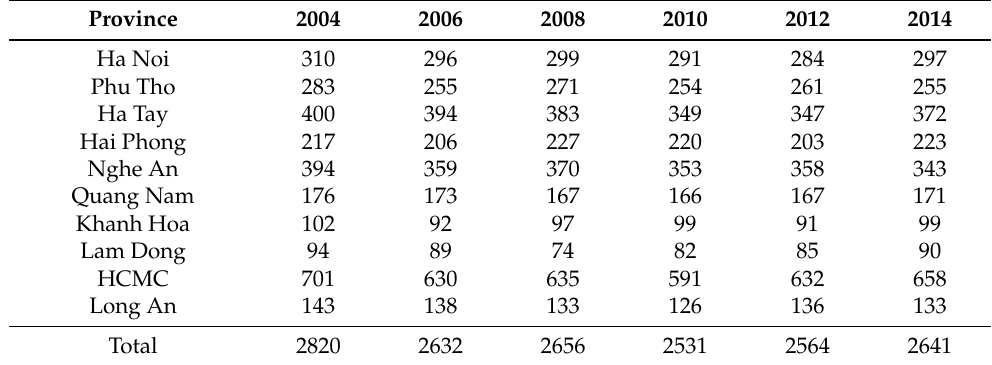
Table 1. Distribution of Firms by Province and Year.